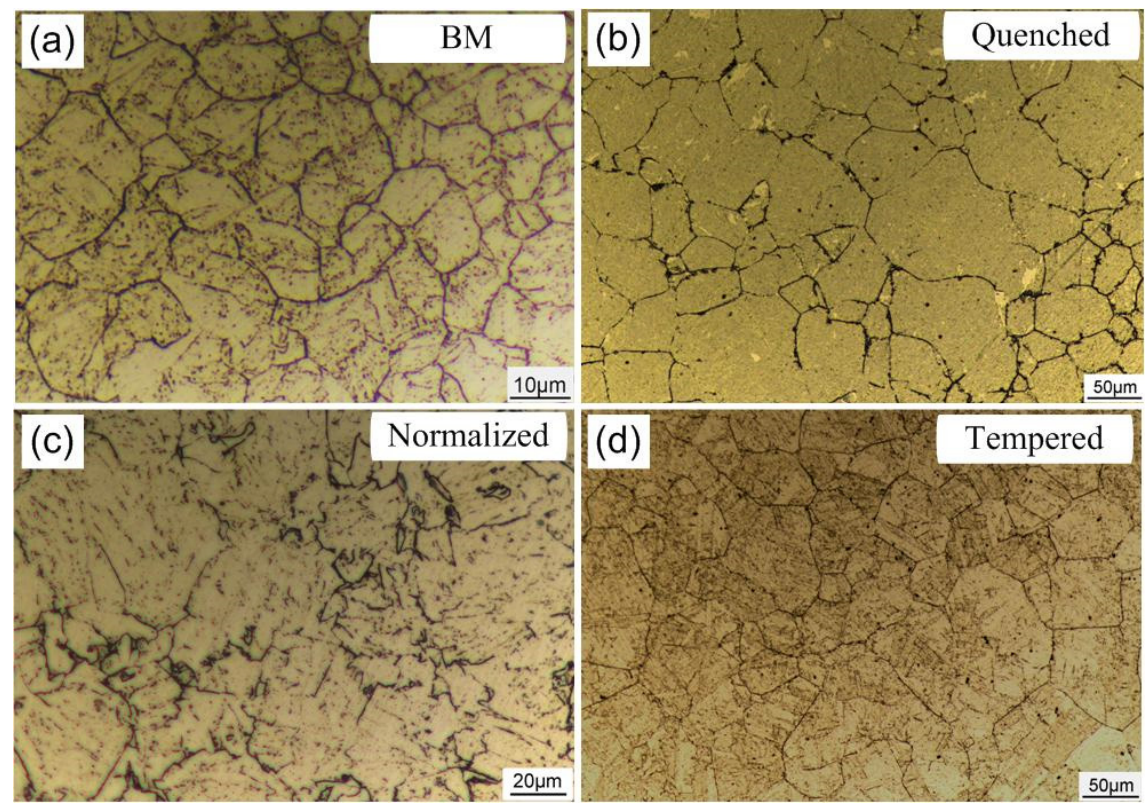
Figure 3. Metallographic diagram of the prior austenite grain boundaries of the base metal (BM) ( a ), quenched steel ( b ), normalized steel ( c ), and tempered steel ( d ).